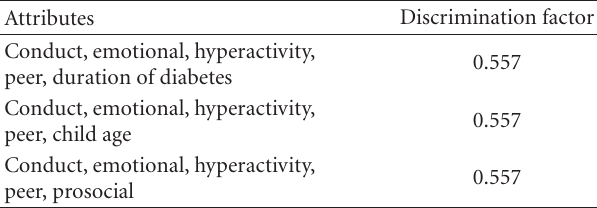
Table 5: Discrimination factor for one attributes. Table 6: Discrimination factor for five